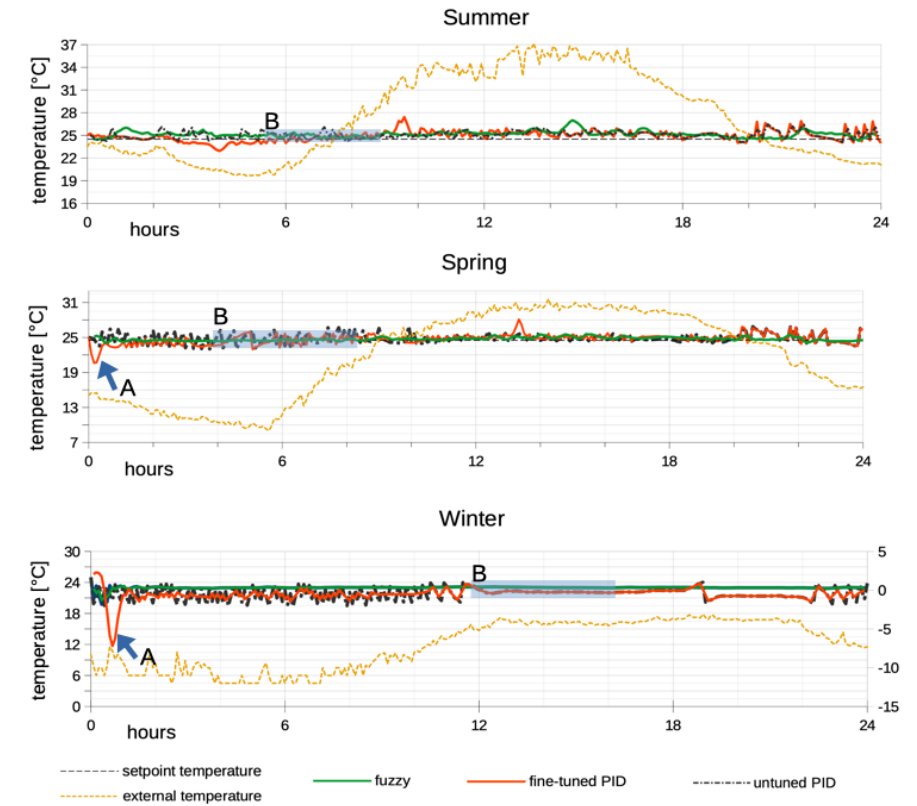
setpoint at a constant outdoor temperature was used in the tuning stage of the fine-tuned controller; due to the standard use of this and conditions deviating from normal operation of the AHU, description of this examination was omitted.